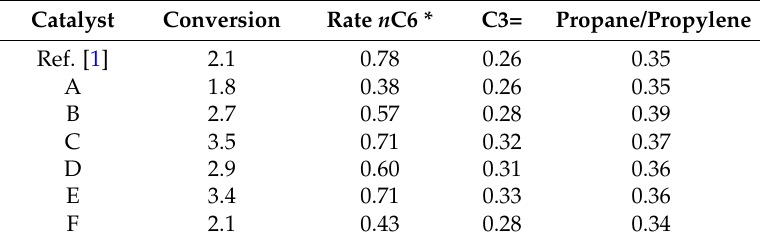
Table 3. Data obtained in the n -hexane catalytic cracking